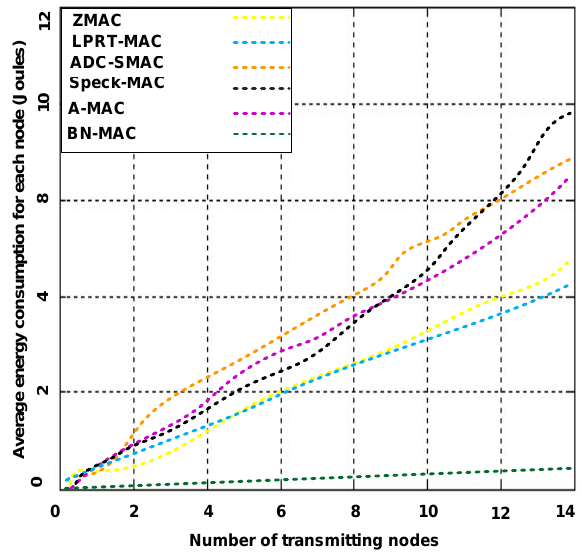
Figure 10. Energy consumption during heavy traffic using a low duty